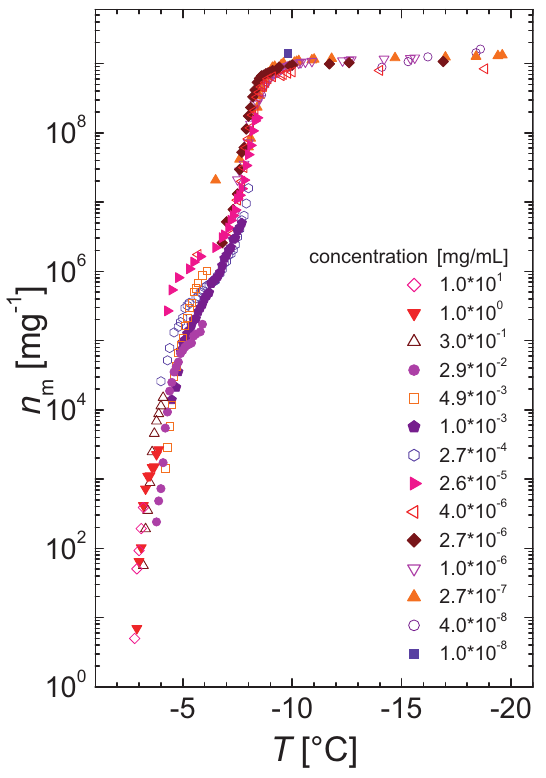
Figure 10. BINARY data represented as number of INM per dry Snomax mass, n m , as a function of temperature, for all data shown in Fig. 5 and using identical